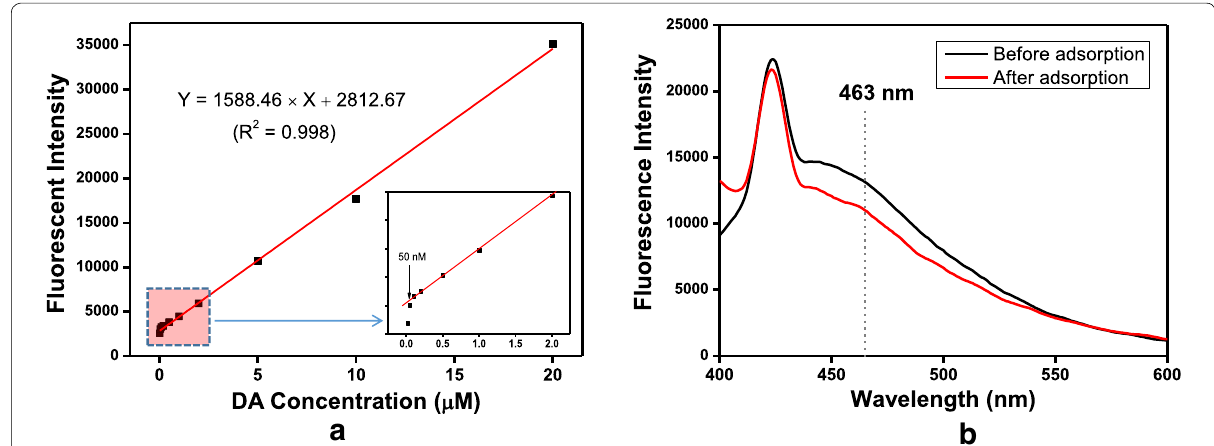
Fig. 4 a Standard curve of dopamine (DA) concentration vs. fluorescence intensity of polydopamine (PDA) at 463 nm. b Comparative fluorescence spectra of PDA obtained from DA that remained in supernatant before and after adsorption using 3‑aminophenylboronic acid‑functionalized